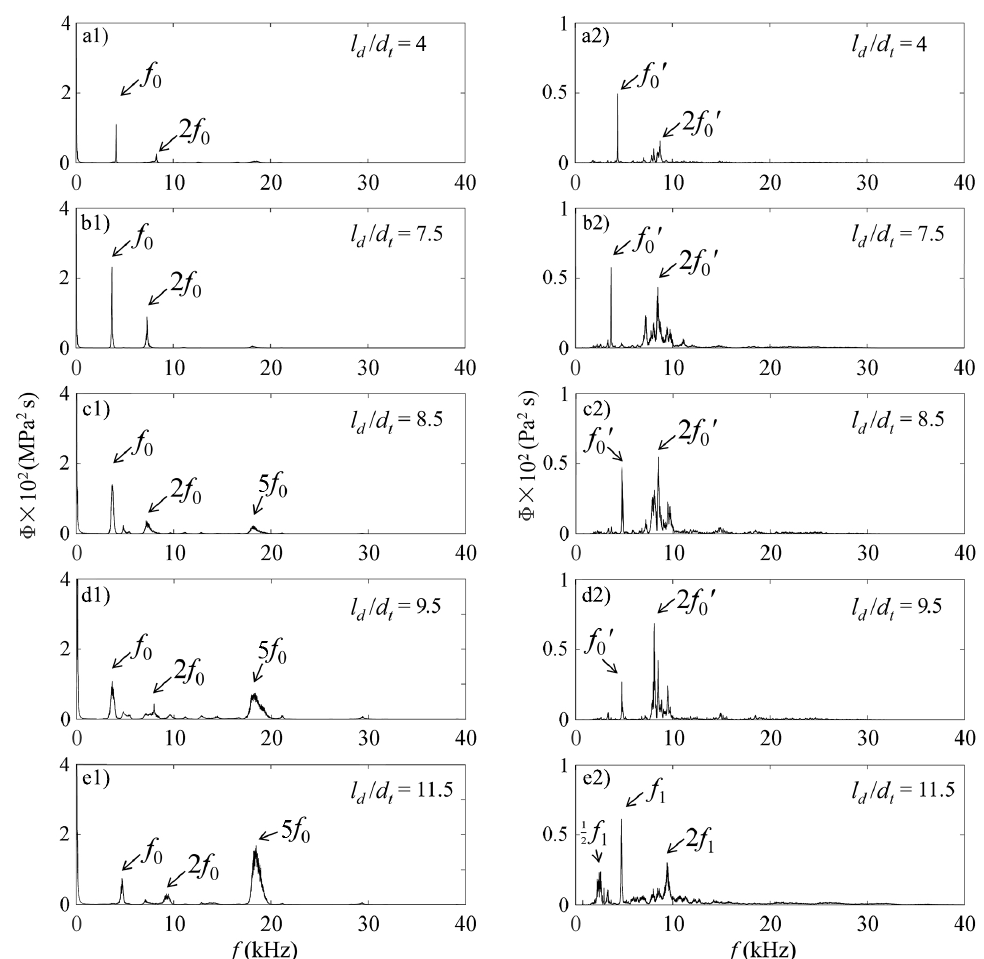
Figure 11. Spectra of the self-resonating oscillations (left column) and the cavitation noise (right column) at α = 0 ◦ . ( a1 , a2 ) l d / d t = 4; ( b1 , b2 ) l d / d t = 7.5; ( c1 , c2 ) l d / d t = 8.5; ( d1 , d2 ) l d / d t = 9.5; ( e1 , e2 ) l d / d t =